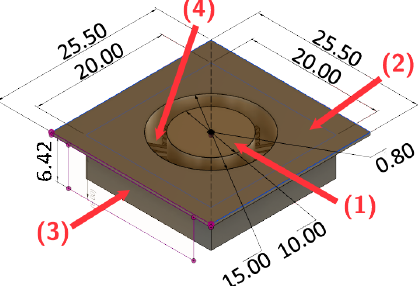
Figure 4. Tip holder design to conform to the Nanoscribe sample holder (dimensions in mm). (1) is the component shown in Figure 3a, (2) mimics the common glass substrates used in Dip-in configuration. (3) adds some rigidity as the small thickness of part (2) otherwise leads to a curved interface. (4) are a series of tiny bars connecting (1) to the holding structure